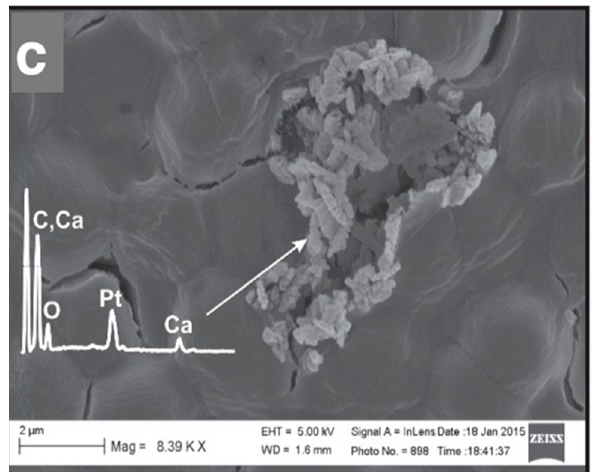
Figure 5. SEM micrographs of the CaCO 3 particles formed in picocyanobacteria biomass Syn. PCC8806 at ( a ) 45 μ M, ( b ) 90 μ M, and ( c ) 180 μ M. The energy-dispersive X-ray spectroscopy (EDX) spectra obtained from the precipitates are presented in all images. The platinum (Pt) peak was due to the sputtering with platinum (see “Materials and Methods”). More images and spectra are presented in the Supplementary Information Figures S10 and S11.